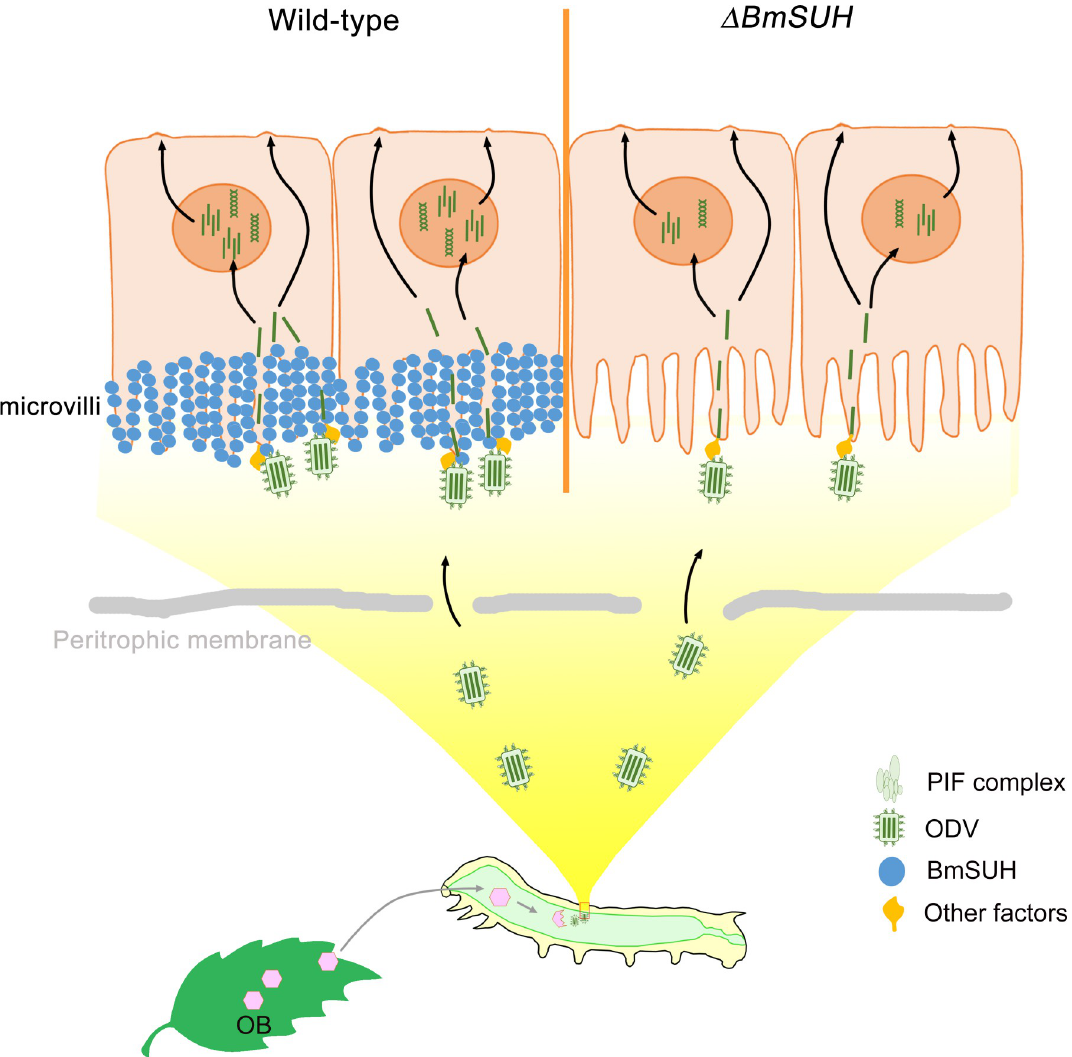
Fig 8. Proposed model of baculovirus oral infection in wild-type or BmSUH mutants. BmSUH is widely distributed in the microvilli of Bombyx mori . After ODV virions traverse the peritrophic membrane, PIF complex binds to BmSUH and other host factors in the microvilli of epithelial midgut cells. Then the ODV virions fuse with microvilli, releasing nucleocapsids into the cytoplasm. In BmSUH mutants, PIF complex could not bind to BmSUH. The loss of BmSUH reduced the ODV entry and led to a lower efficiency of oral infection (the right part). The DNA clipart was obtained from the “Icon Library” of iSlide under a CC0 1.0 Universal license. The silkworm was drawn based on a clipart obtained from the “Icon Library” of iSlide under a CC0 1.0 Universal license. Copyright: https://en.islide.cc/copyright-notice.